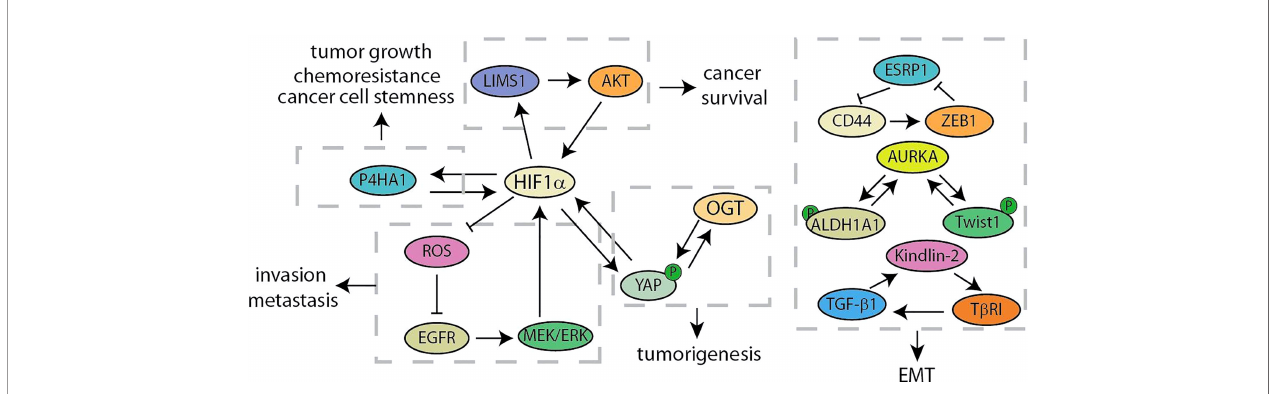
FIGURE 5 | Summary of hypoxia and glucose metabolism and EMT related feedback loops in pancreatic